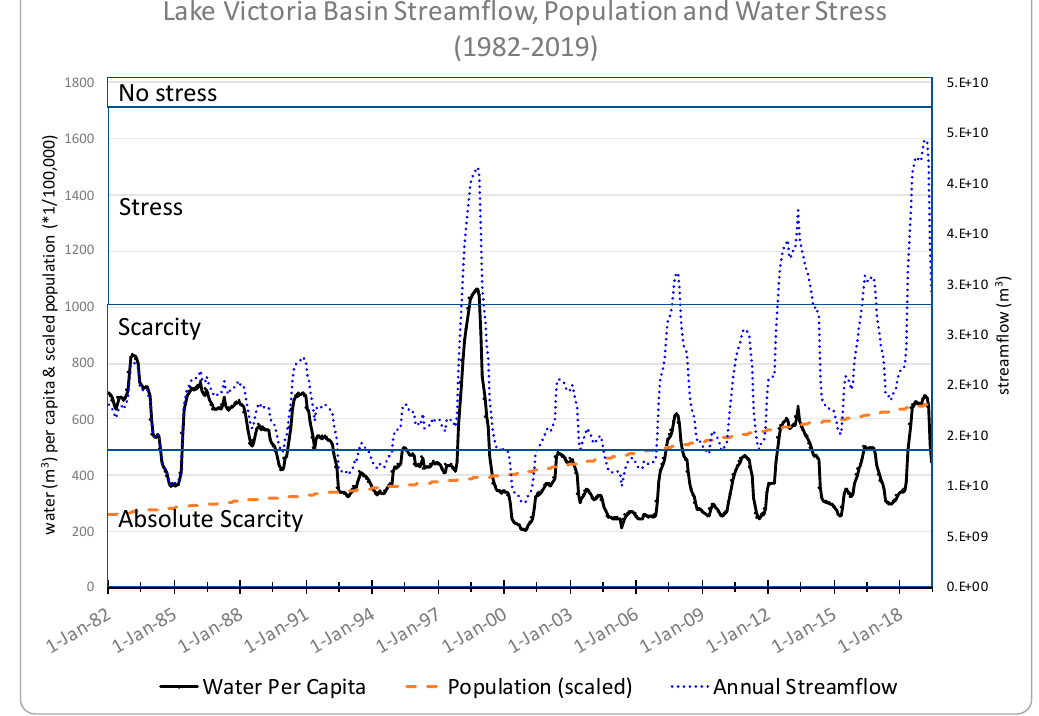
Figure 6. Time series of the Lake Victoria Basin showing changes in streamflow, population and water scarcity classification. The blue line shows annual streamflow at the mouth of Lake Victoria basin, with a positive trend since 2000. The orange line shows the total basin population, values interpolated from 1975, 1990, 2000, and 2015 GHS estimates. The black line is water availability per capita. Color blocks denote Falkenmark thresholds (Table 2). Despite the positive trend in streamflow since 2000, water available per capita has not increased.